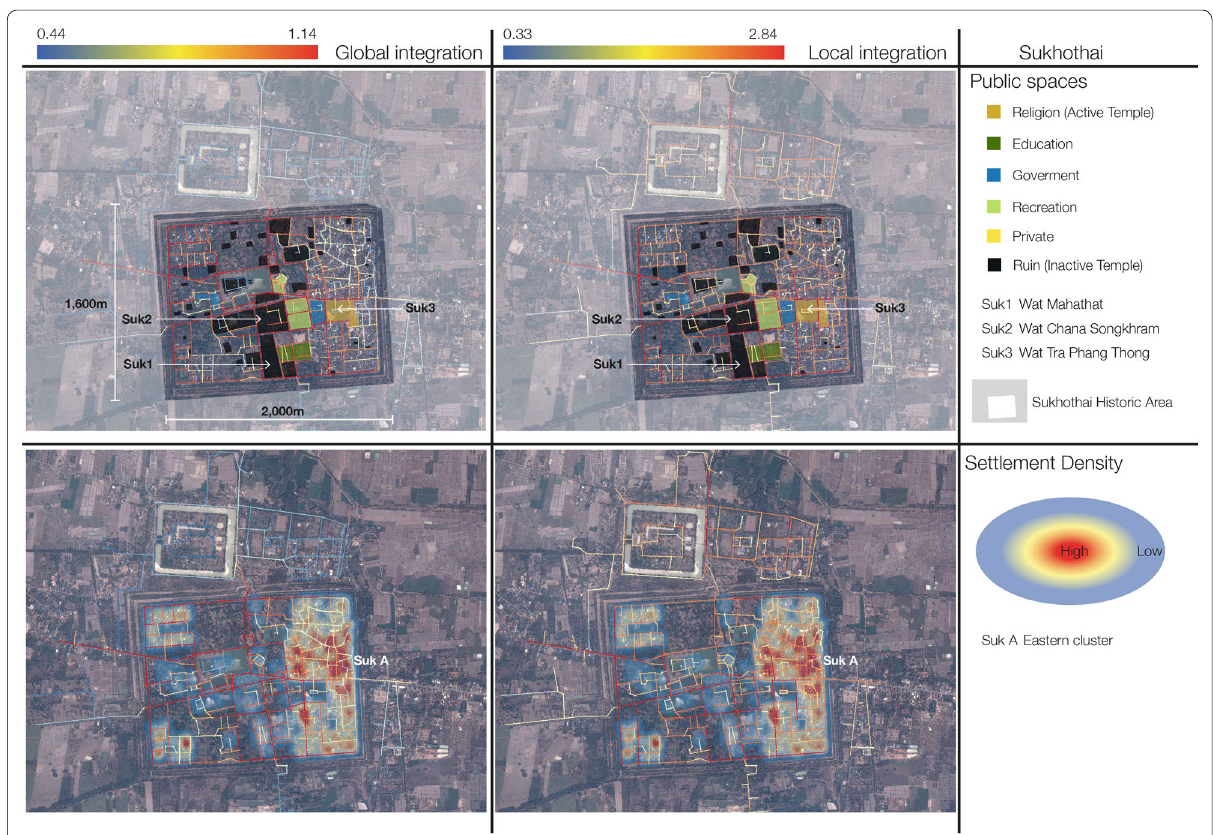
Fig. 10 Analysis of Sukhothai’s spatial